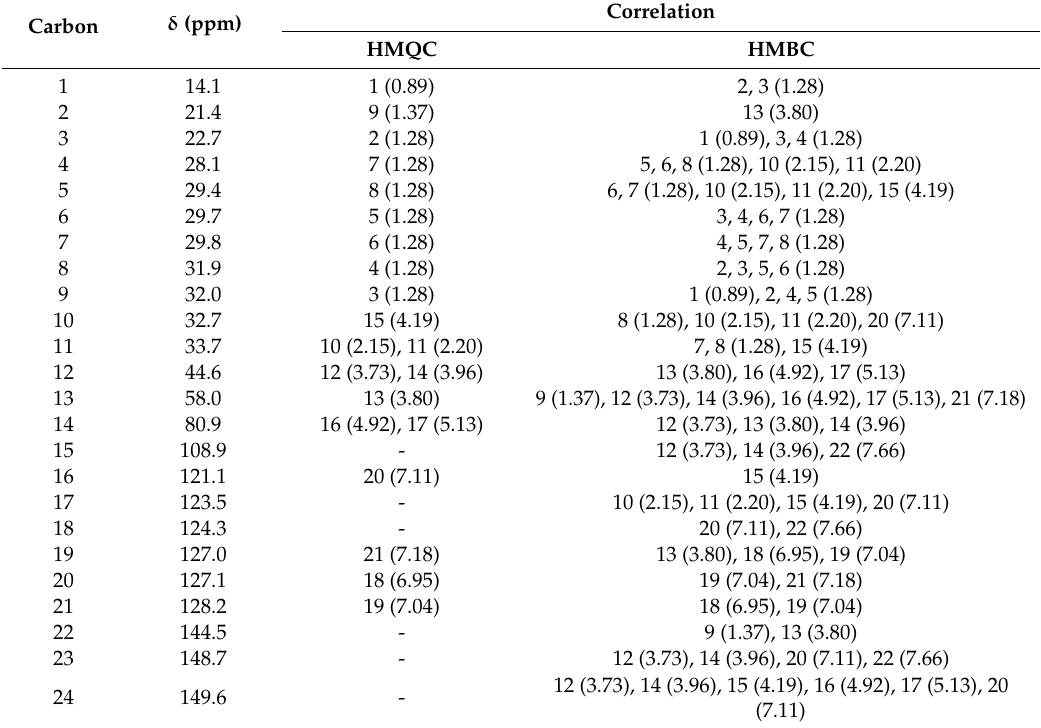
Table 2. Correlations for compound 5 in the HMQC and HMBC